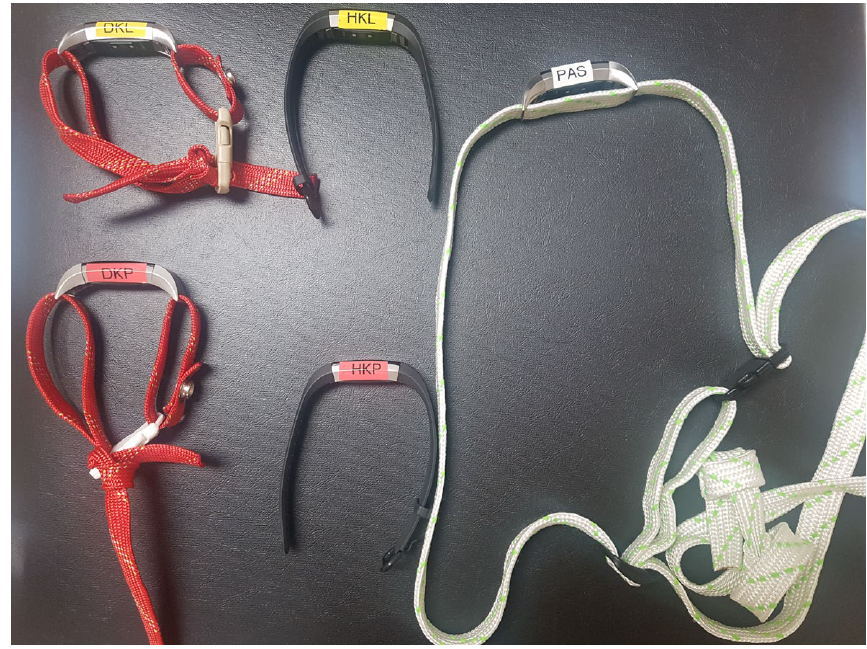
Figure 1. Activity trackers, DKP = right lower limb, DKL = left lower limb, HKL = left upper limb, HKP = right upper limb, PAS = waist.